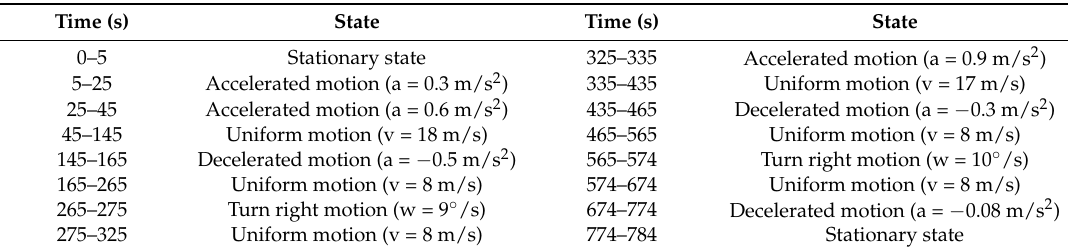
Table 3. The process of the vehicle’s motion.